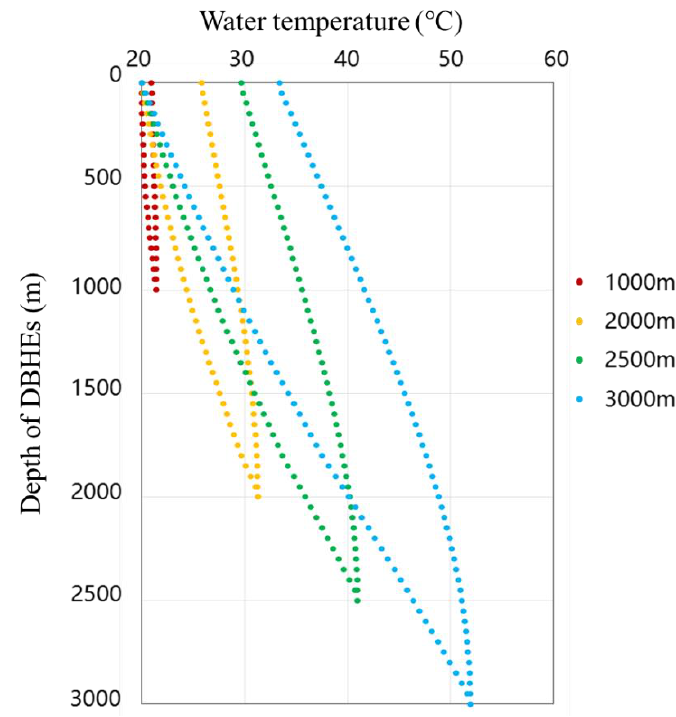
Figure 23. Effect of DBHEs depth on the water temperature distribution.